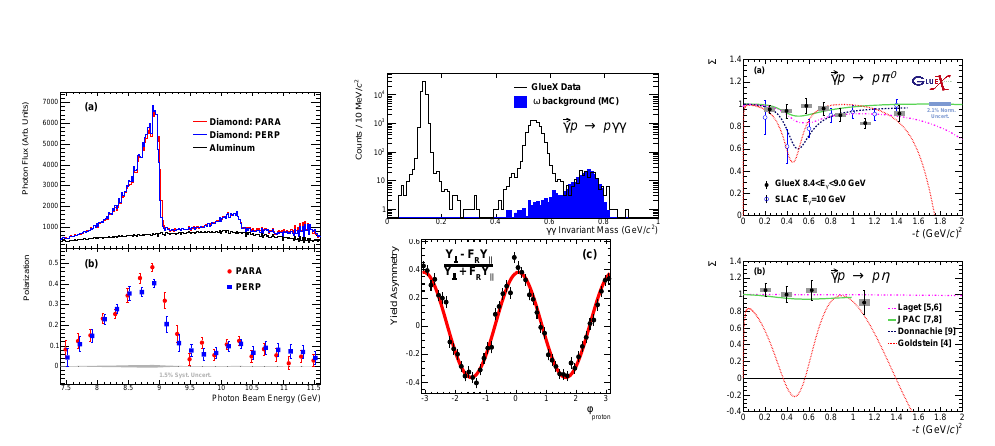
Figure 3. First GlueX results [4]. Left (a) - photon beam spectrum; (b) - the measured photon linear polarization, for two crystal orientations. Center top - the mass spectra of two photons; bottom - the π 0 asymmetry measured with two orientations of the crystal radiator. Right (a) - measured asymmetry for π 0 ; (b) - measured asymmetry for η .